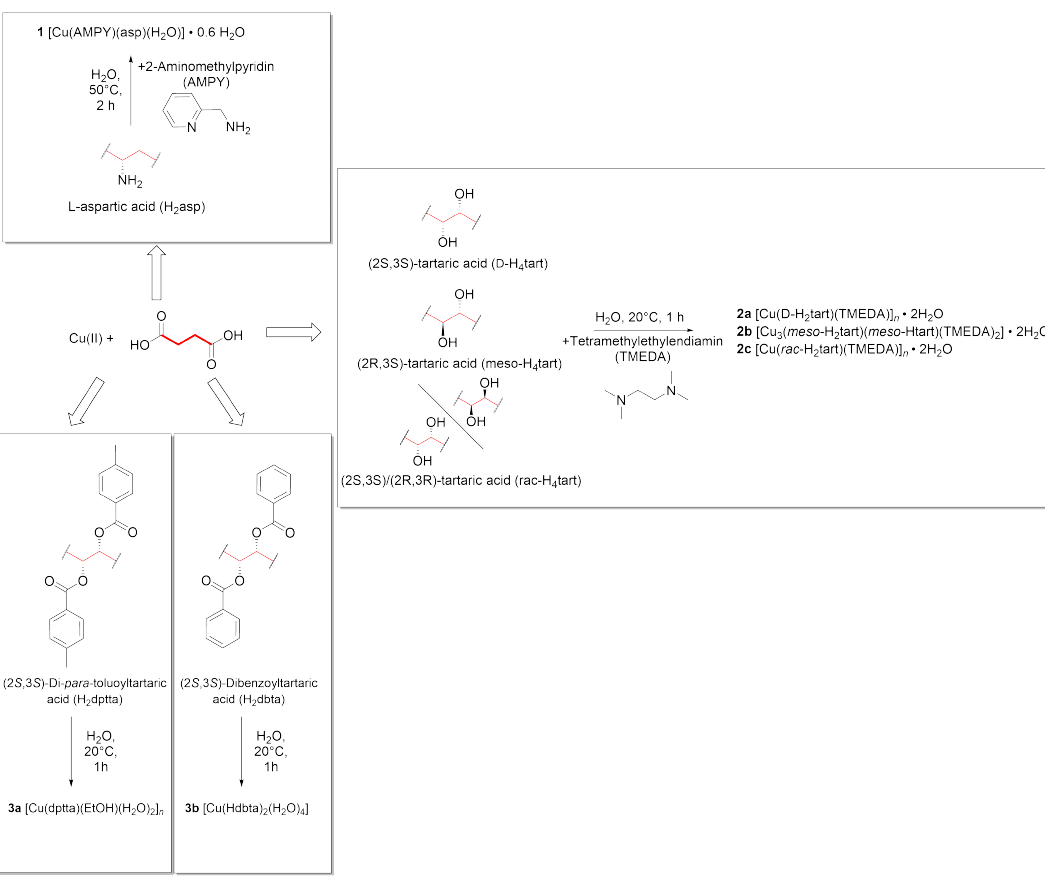
Figure 1. Schematic overview of the compounds synthesized and structurally characterized in this